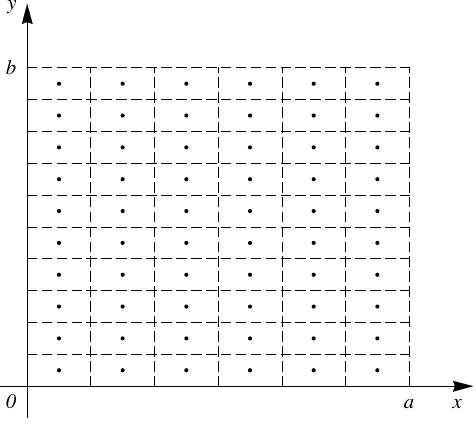
Figure 2. Mesh for the cross-section of the ingot used in the finite difference